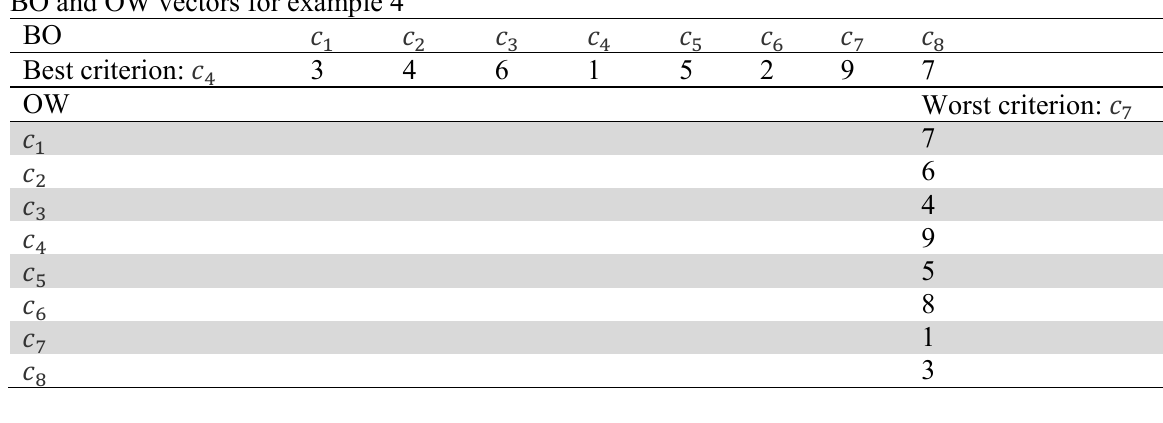
Normalized suppliers score for raw material(C in the main study) Criterion Supplier